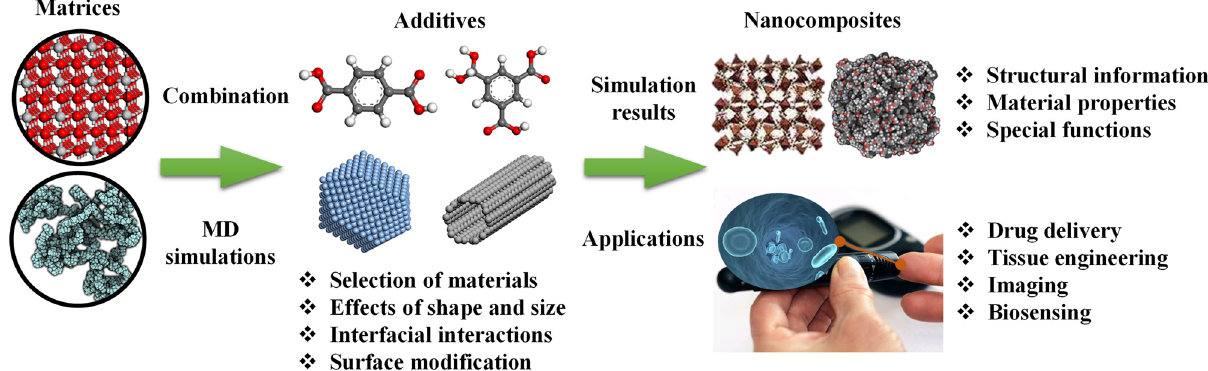
Figure 4: Schematic diagram of nanocomposites reinforced with nanosized additives in MD simulations and biomedical